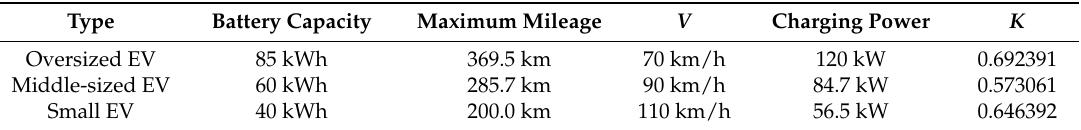
Table 2. EV parameters. Table 2. EV